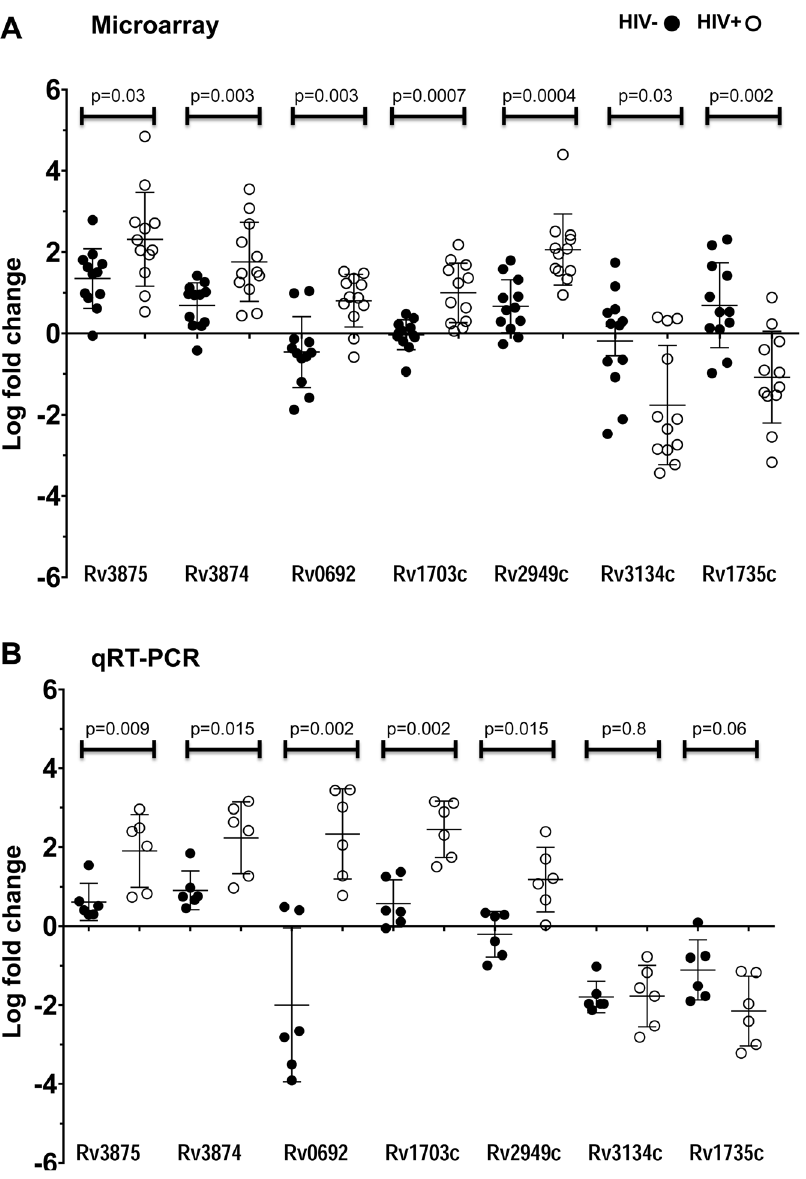
Figure 7. qRT-PCR validation of microarray results. Log 2 fold-changes in expression of seven selected genes in M. tb replicating in blood from HIV- donors (black dots) or from HIV + patients (open black circles) at 96 hr compared to M. tb logarithmically growing in 7H9 broth media. (A) Microarray results from 6 biological replicates (6 different donors) per condition (blood from HIV- or HIV + donors) with 2 technical replicates (Cy5/Cy3 dye swap) (total 12 values per condition are shown). (B) qRT-PCR results from M. tb replicating in blood from 6 different donors per condition (HIV- or HIV + ) (total 6 values per condition are shown). Y-axis values (Log 2 fold change) of $ 1 indicate upregulation and values # -1 indicate down-regulation. (For qRT-PCR, numbers of transcripts were normalized to copies of 16S rRNA.) P-values indicate the statistical difference between the average log 2 fold-change of a gene in blood from HIV- subjects compared to HIV + patient blood by Mann-Whitney two-tailed test.